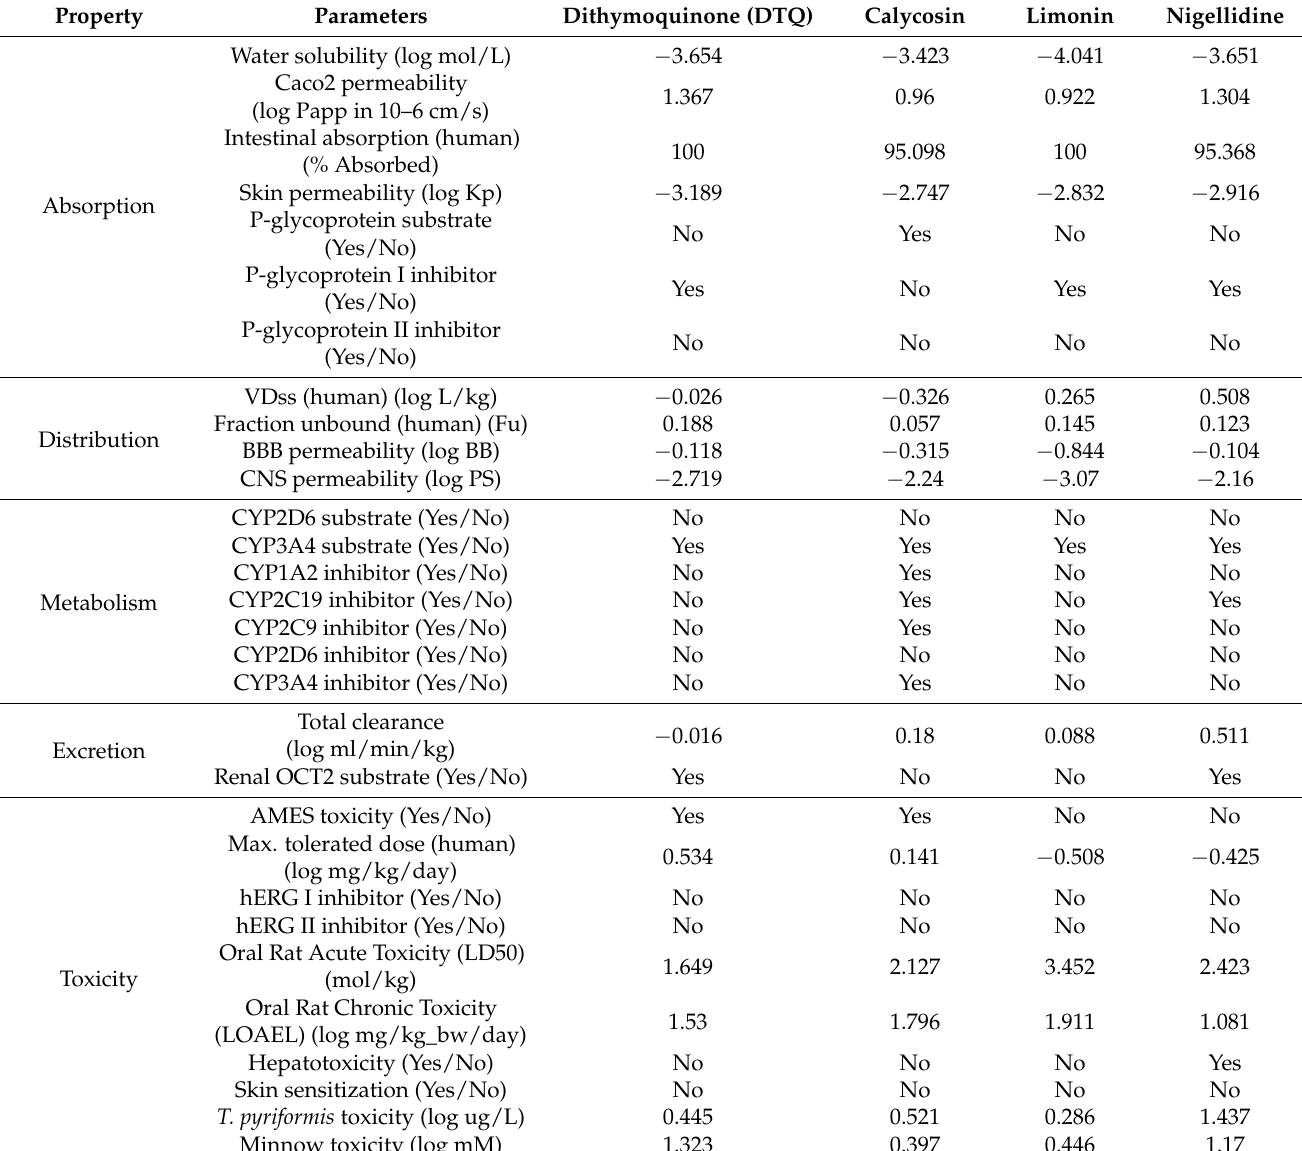
Table 2. ADME properties of top selected